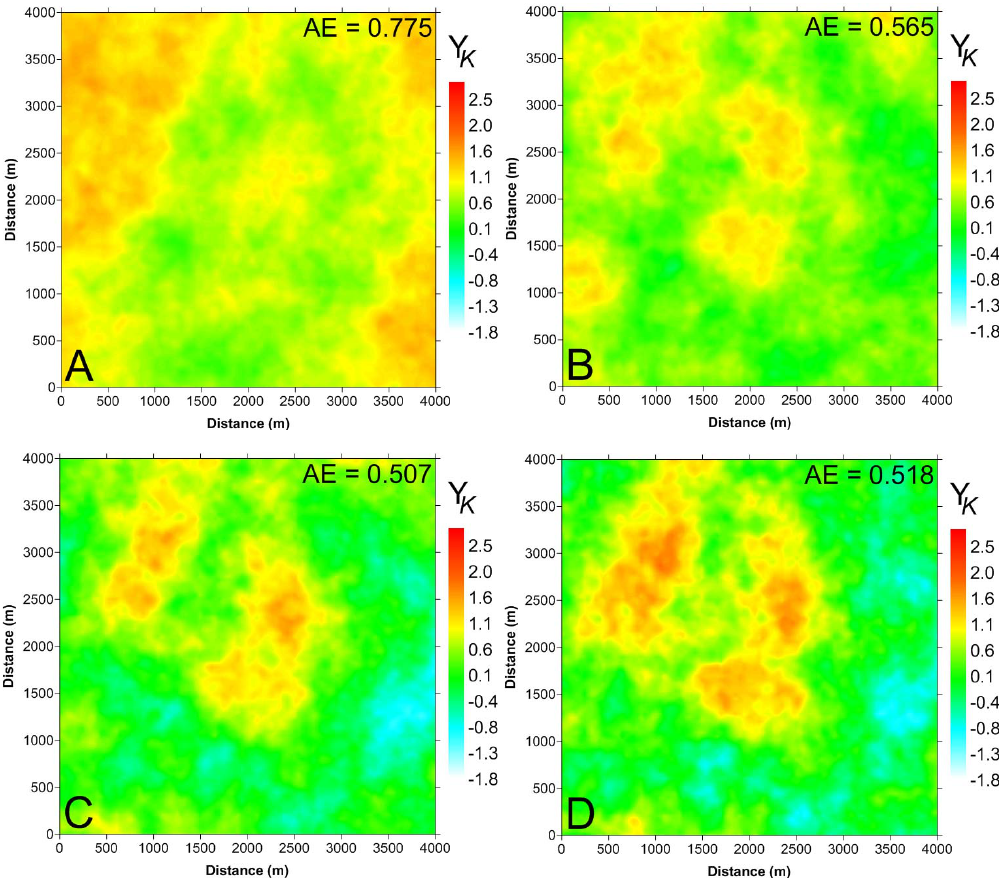
Fig. 15. Ensemble mean of updated Y K ensemble for the (A) 1st iteration, (B) 2nd iteration, (C) 3rd iteration, and (D) 4th iteration, for the case where the true values of and are 0.301 log m day − 1 and 0.500(log m day − 1 ) 2 , respectively. Compare to the true state in Fig. 13. The forecast AE values was 1.106.